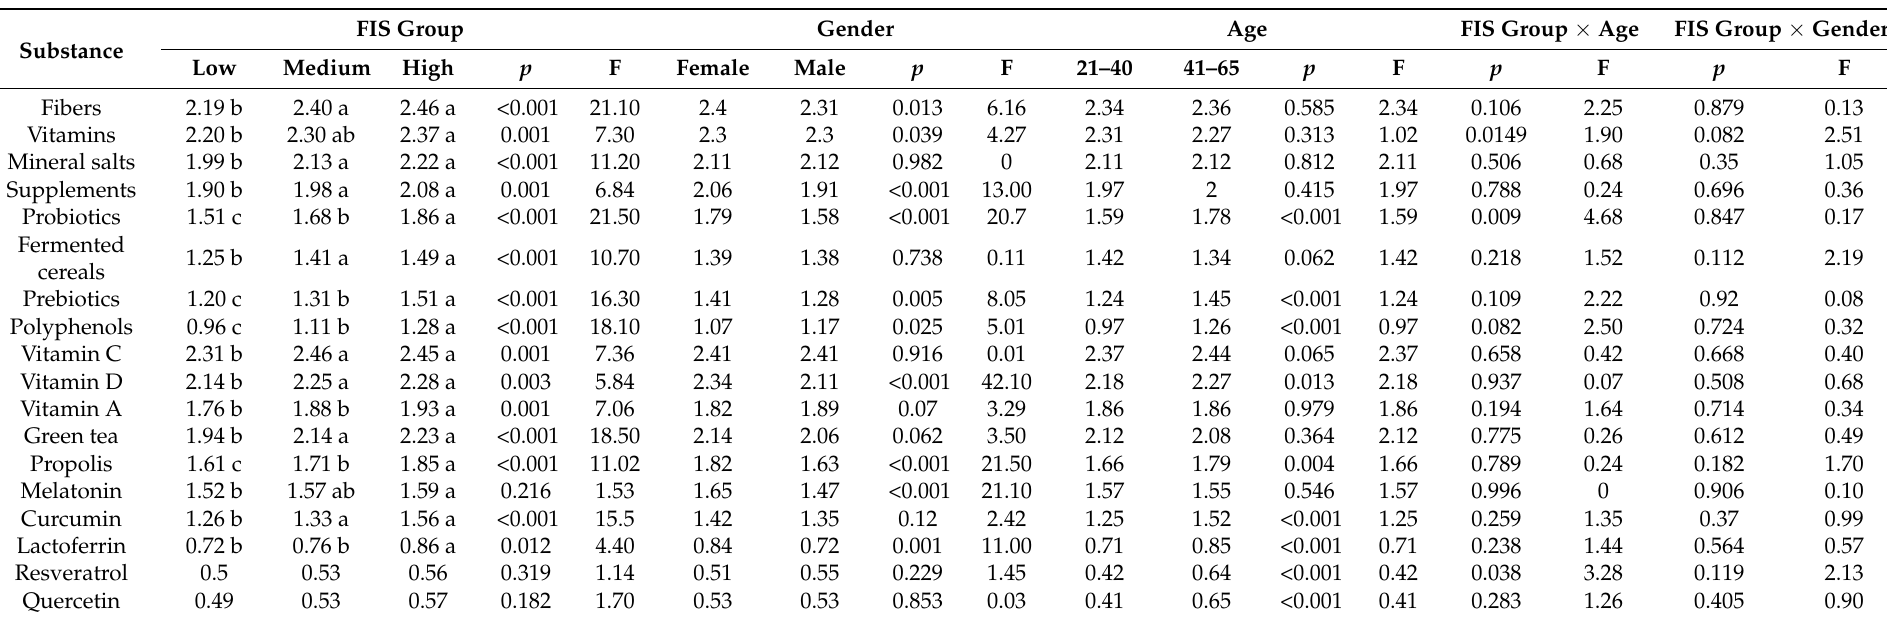
Table 7. Three-way ANOVA model on the knowledge level of different bioactive compounds during the COVID-19 period. FIS group, gender, and age were used as fixed factors with the interactions FIS group × Age and FIS group × Gender. Tuckey’s post hoc test was also used to test the differences between the FIS